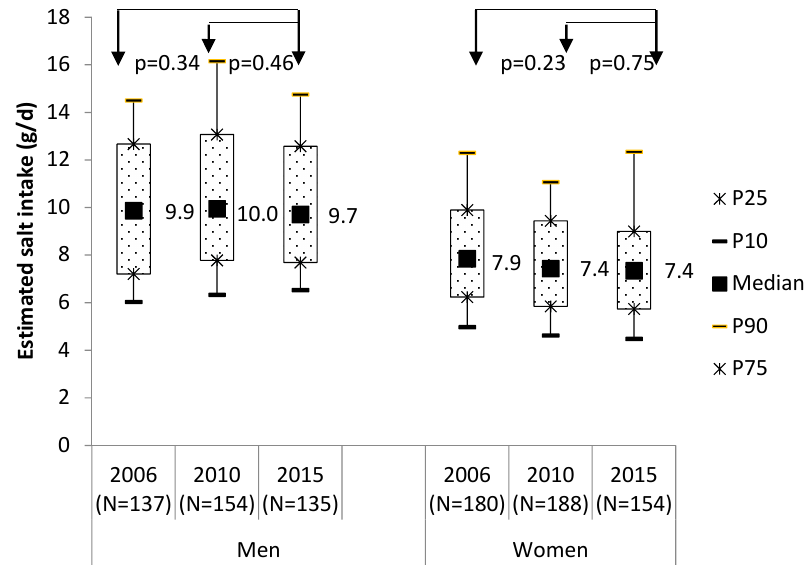
Figure 3. Salt intake (g per day) estimated from 24 h urine excretion in 2006, 2010 and 2015, correcting for age, education and day of the week. The proportion of participants reporting the use of discretionary salt was lower in 2010 as compared to 2006 (81% in 2010 versus 88% in 2006; p = 0.009). In 2015, the use of discretionary salt (83%) was not statistically significant different compared to 2010 ( p = 0.46).